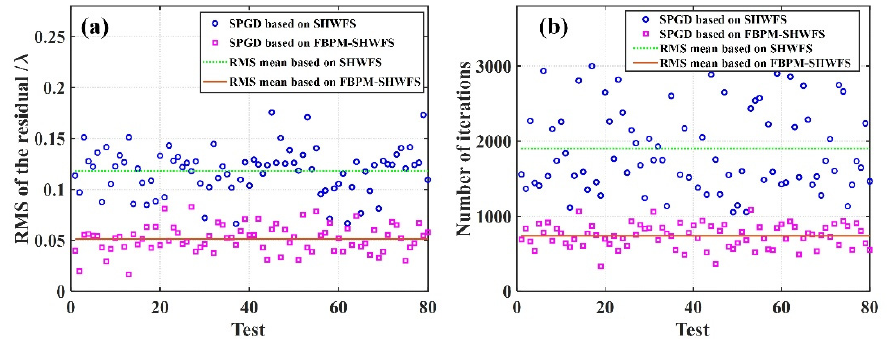
Figure 8. Comparison of the stability of wavefront reconstruction for the SHWFS and the FBPM- SHWFS. ( a ) RMS of residual wavefront. ( b ) Number of iterations.